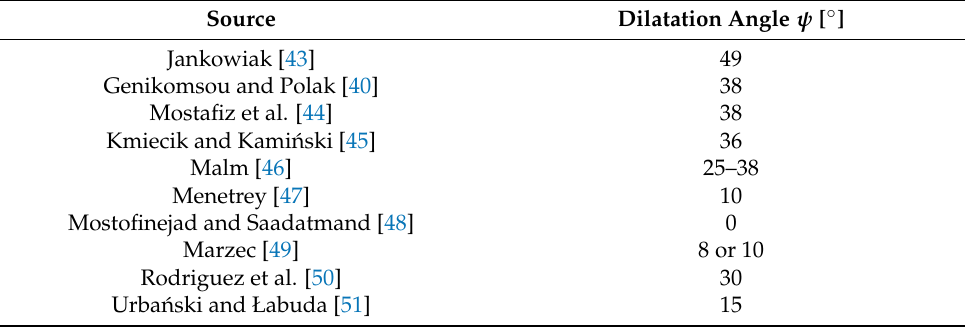
Table 3. Values of dilatation angle as suggested by other authors.